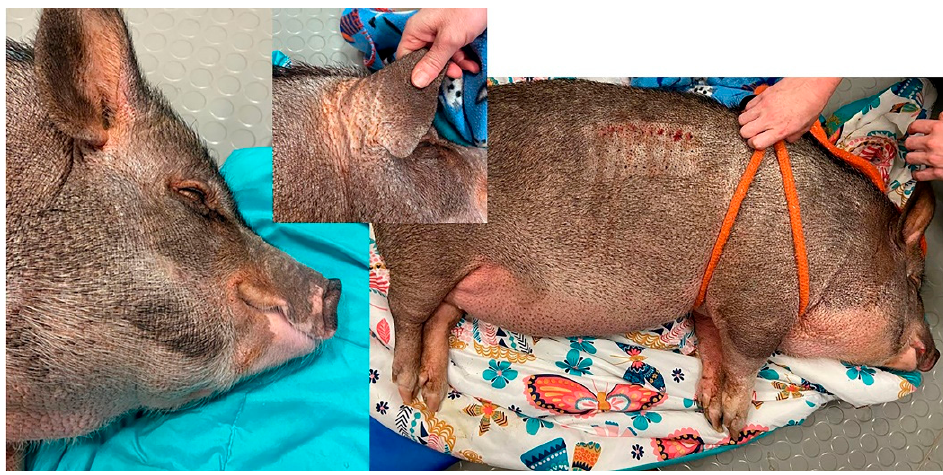
Figure 5. Pot belly pig presenting for pruritic dermatitis of face (periocular and perioral), ventral abdomen, and legs linked to environmental allergies and responsive to allergen specific immunother-